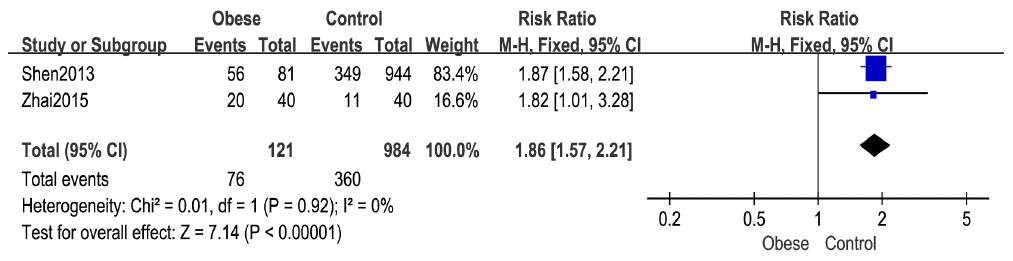
Figure 3. Forest plot for number of girls with menarche between the obese group and control group.